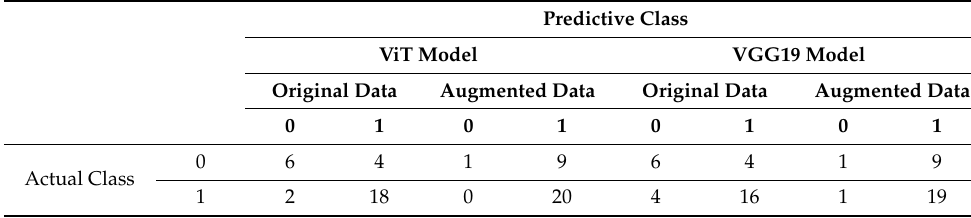
Table 5. Binary classification confusion matrix of ViT and VGG19.